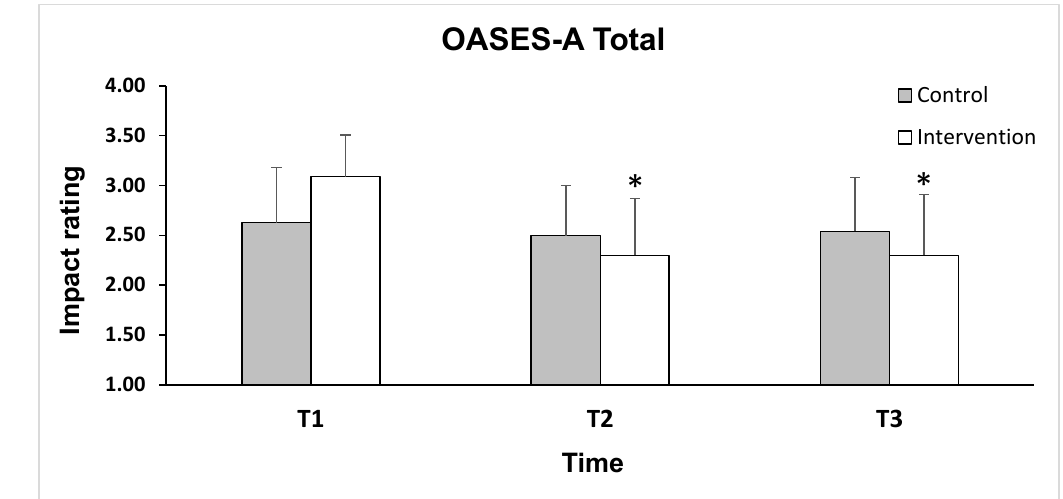
Figure 3. Effect of IBSR intervention on the Overall Assessment of the Speaker’s Experience of Stuttering-Adults (OASES-A) total score in comparison to control group. Data are displayed as mean score ± standard deviation. T1 = before intervention, T2 = after intervention, and T3 = one month after intervention. Impact rating score rates the severity of the stuttering